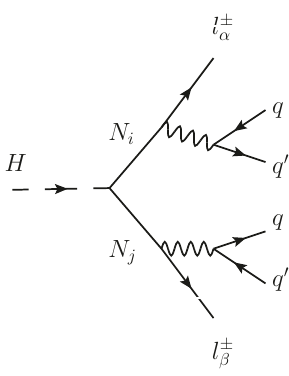
Figure 4 . Higgs decay to two heavy neutrinos leading to displaced